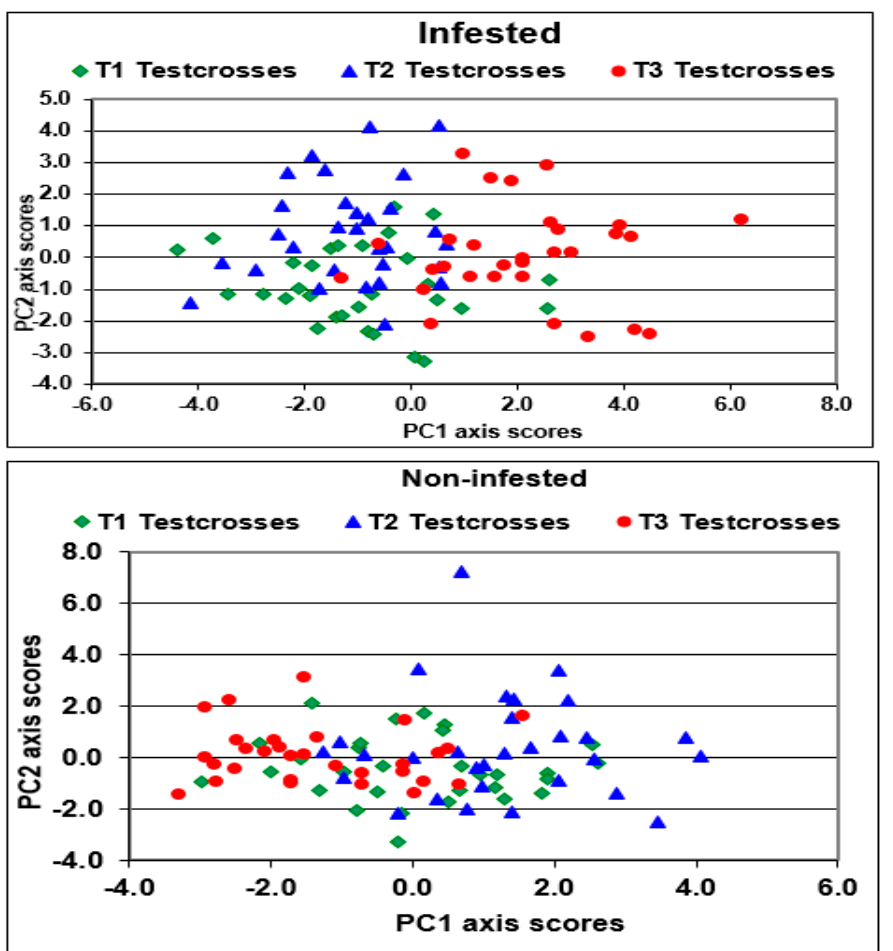
Figure 1. Scatter plot of testcrosses involving three testers evaluated under Striga -infested and non-infested conditions at four test environments in Nigeria. Where T1 = Tolerant tester, T2 = Resistant tester and T3 = Susceptible tester